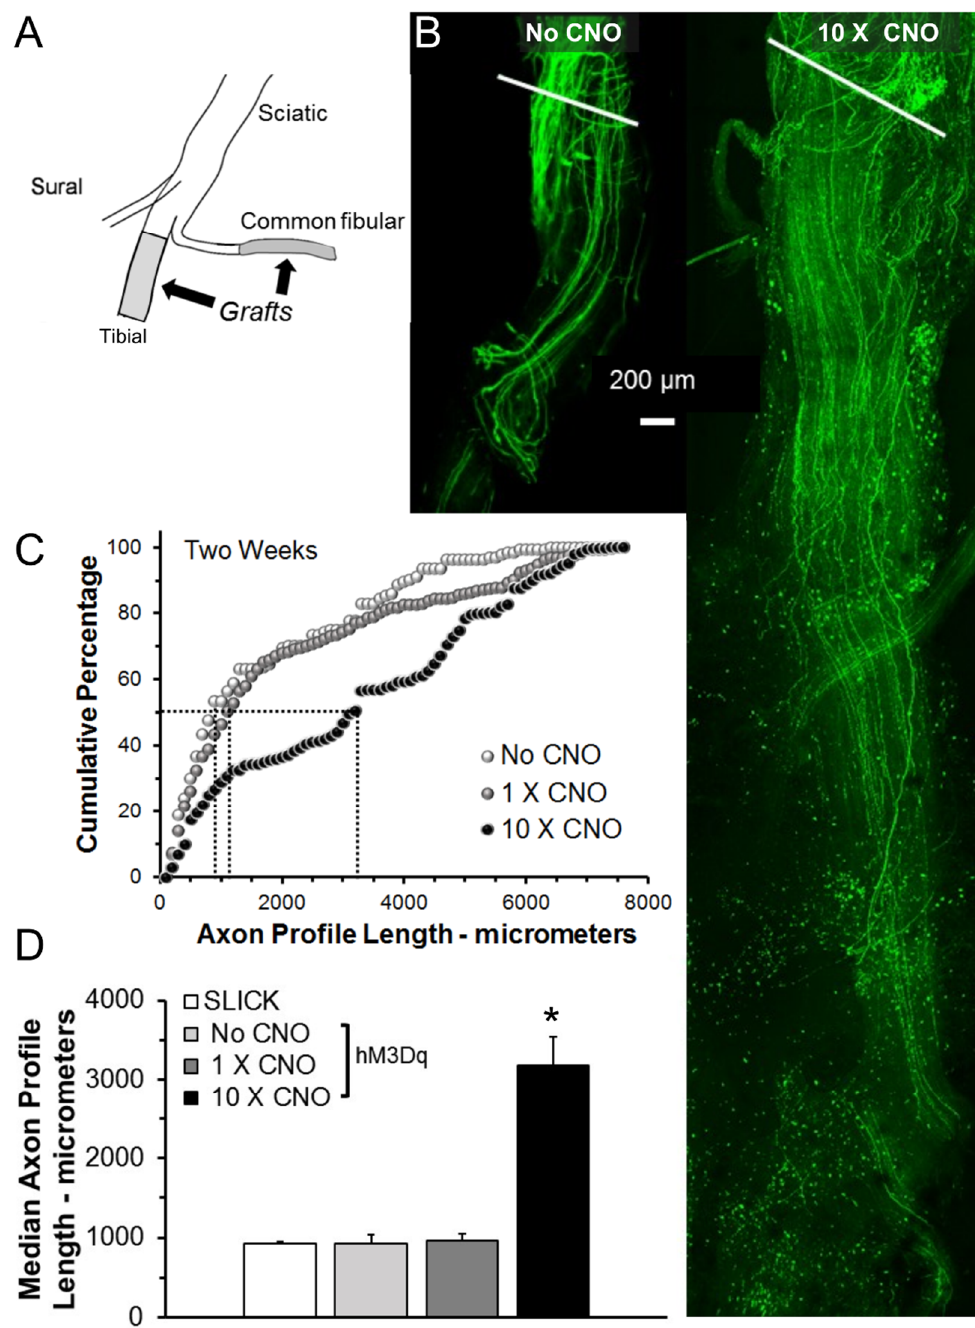
Figure 1. ( A ) Diagram of the experimental approach. ( B ) Images from a single 10-micrometer-thick optical section through repaired nerves from SLICK::hM3Dq mice harvested two weeks after injury. White lines indicate site of sciatic nerve Tx-repair. ( C ) The distributions of axon profile lengths measured two weeks after nerve injury. Dashed lines = medians ( D ) Average median axon profile lengths ( ± SEM, N = 5), * = p < 0.05 vs. all others. CNO: clozapine-N-oxide.